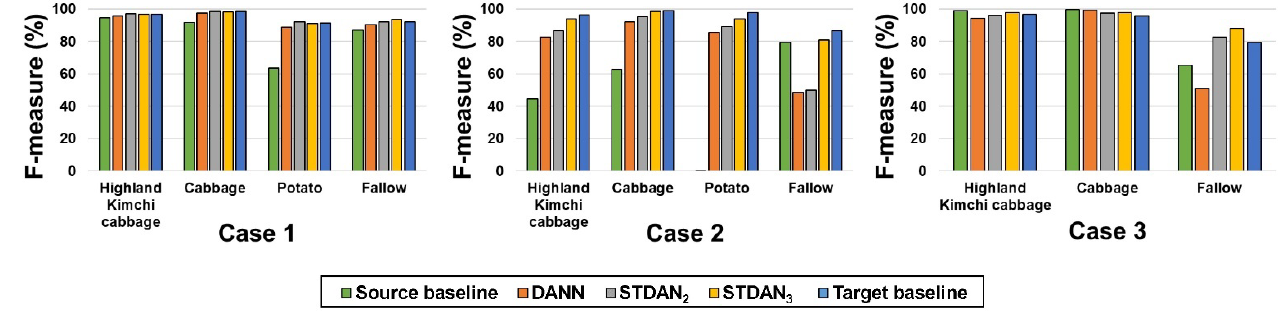
Figure 13. The class-wise F-measure of the five classification results for the three domain adaptation cases in Gangwon.